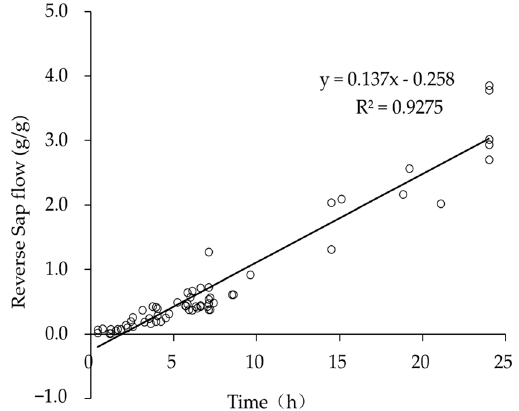
Figure 8. The relationship between the reverse flow and the duration of the high relative humidity